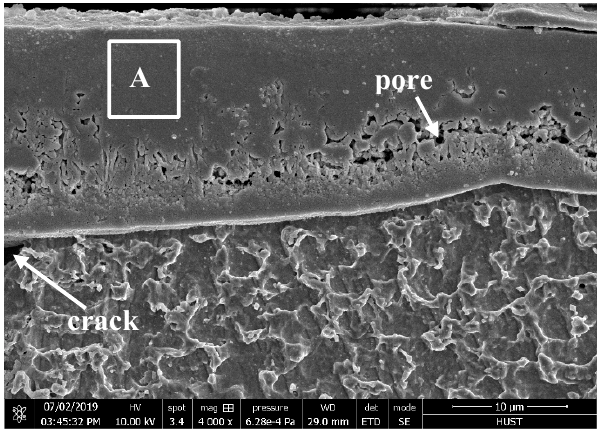
Figure 4. SEM image of the laser-clad La 2 Zr 2 O 7 coating.